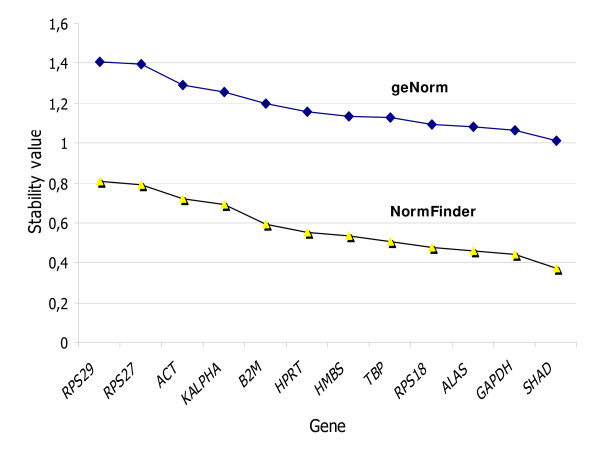
geNorm and NormFinder stability values of 12 reference genes in 46 HNSCC and normal matched mucosa. Upper line with rhombus = stability values from geNorm; Lower line with triangles = stability values from NormFinder.